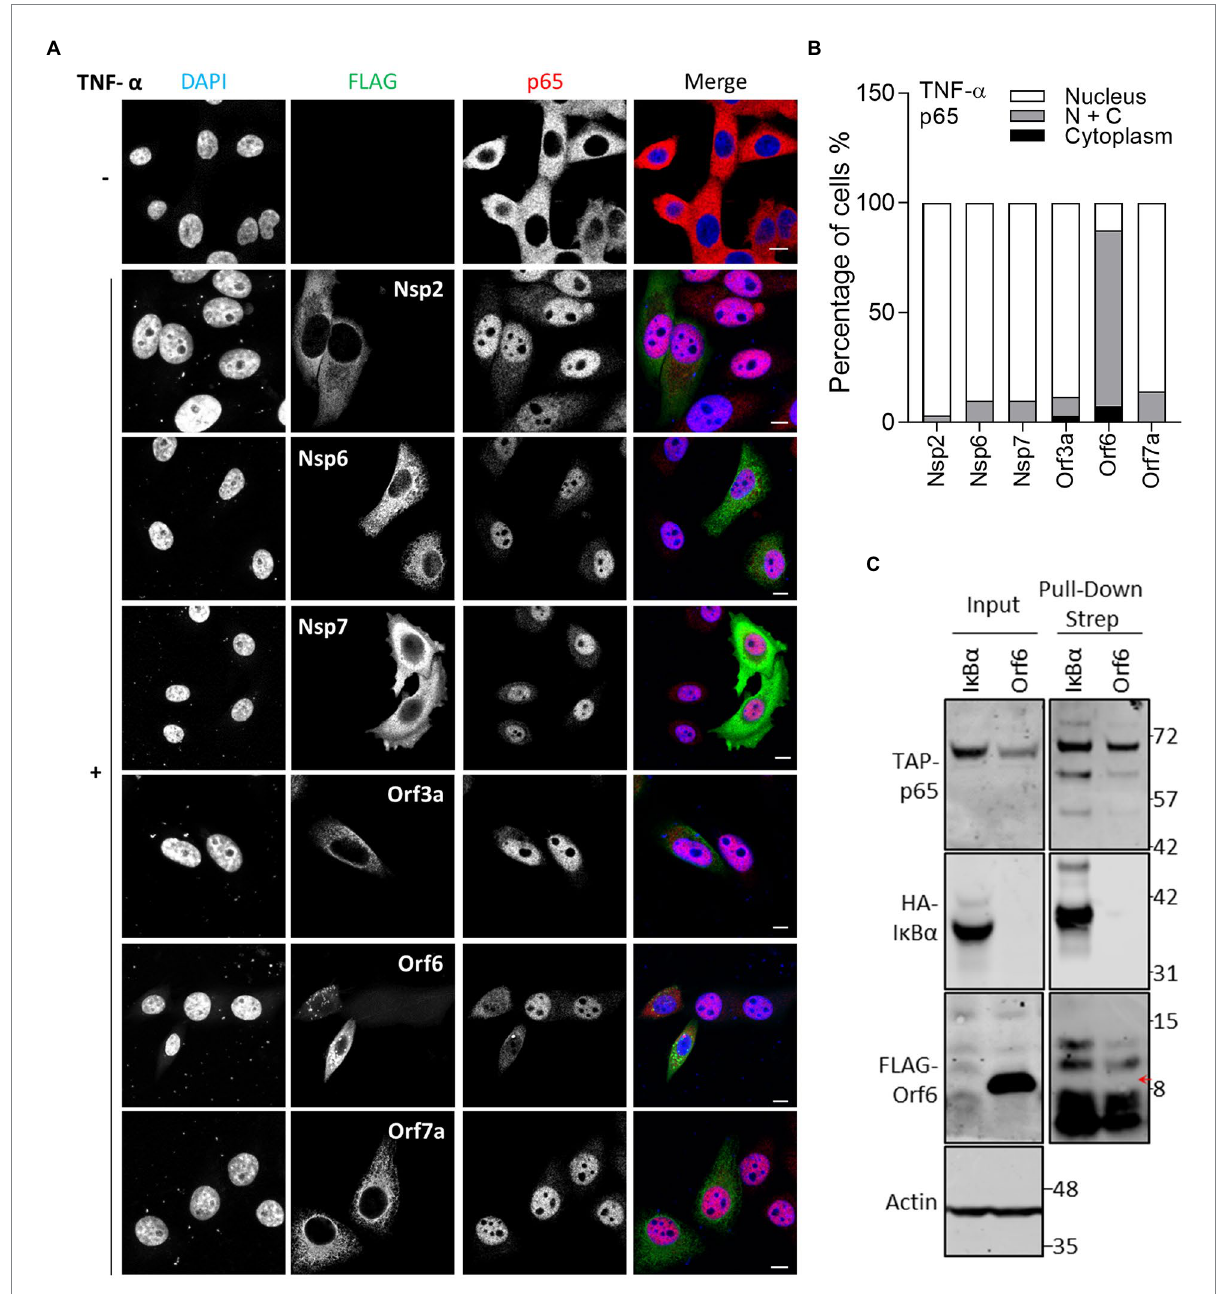
FIGURE 5 Immunofluorescence microscopy (IF) analysis of the effect of SARS-CoV-2 viral proteins on TNF- α -induced p65 relocalisation. (A) As in Figure 2, except that transfected HeLa cells were stimulated with 40 ng/ml TNF- α for 30 min and then stained for p65. Scale bar, 10 μ m. (B) Quantification of TNF- α -induced p65 translocation ( n ≥ 21 in each condition). N + C represents staining within both the nucleus and cytoplasm. (C) HEK-293 T cells were co-transfected with plasmids encoding TAP-tagged-p65 and HA-tagged-I κ B α or FLAG-tagged Orf6. The following day, transfected cells were starved with medium without serum for 3 h, and then stimulated with TNF- α (20 ng/ml) for 1 h. The stimulated cells were harvested and lysed for pull-down via the TAP-epitope. Inputs (Left) and pull-down samples (Right) were analyzed by immunoblotting with the indicated antibodies. The position of the FLAG-tagged Orf6 protein is indicated by a red